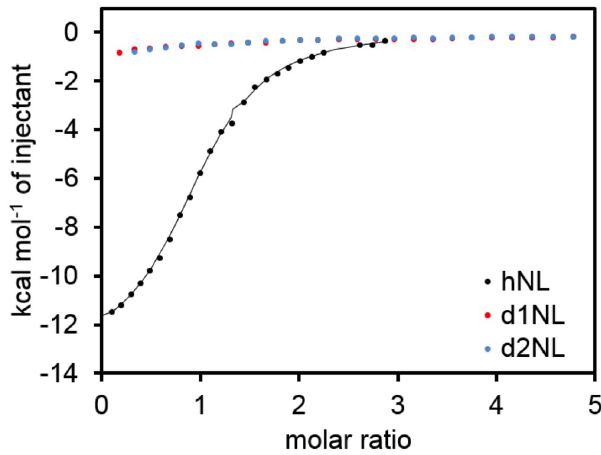
Fig 11. Binding of human and Drosophila Arc N-lobes to a Stargazin